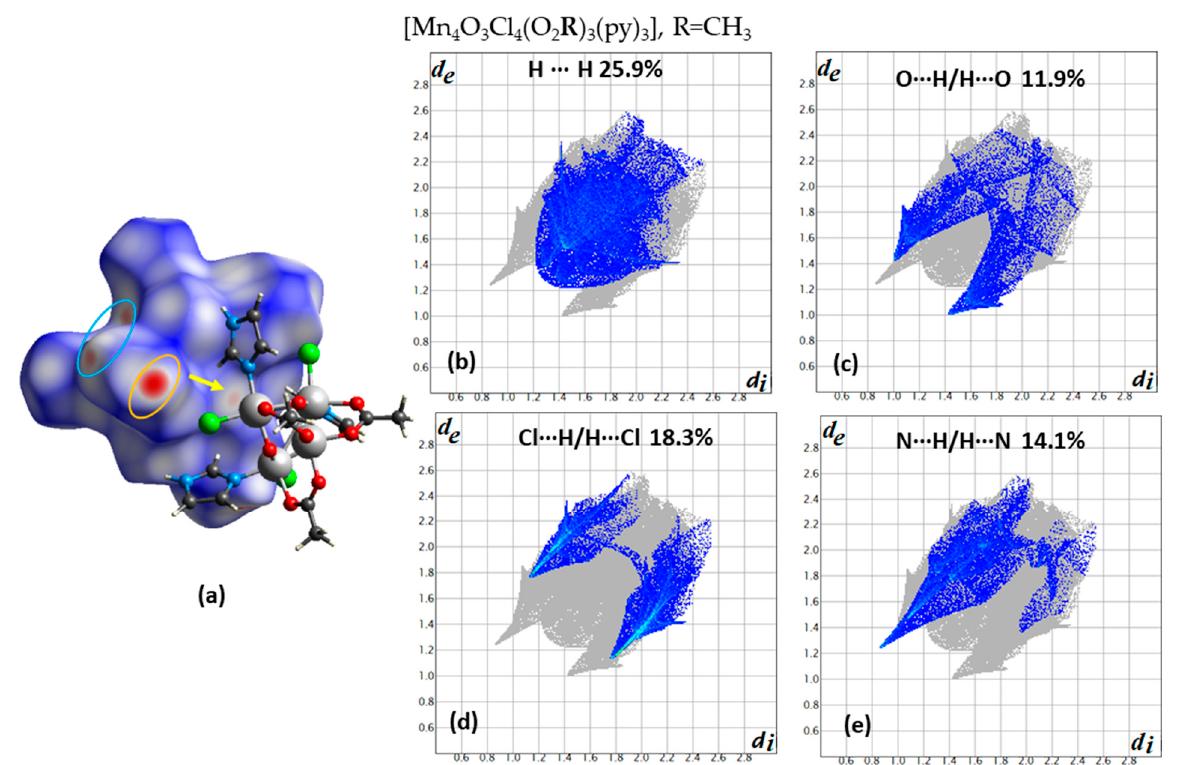
Figure 2. ( a ) A dimer of complexes with one molecule to be surrounded with a d norm decorated HS and the other in a ball and stick presentation for compound 2 . The orange vector in the middle indicates the Cl ∙∙∙ Cl contact points. The red areas in the orange and cyan ellipses indicate H ∙∙∙ N (only donor points are seen for this view) and O ∙∙∙ H/H ∙∙∙ O contact points. Contribution of ( b ) H ∙∙∙ H, ( c ) O ∙∙∙ H/H ∙∙∙ O, ( d ) Cl ∙∙∙ H/H ∙∙∙ Cl, and ( e ) N ∙∙∙ H/H ∙∙∙ N interactions in the fingerprint plot diagram. The outline of the full fingerprint contribution is shown in gray.